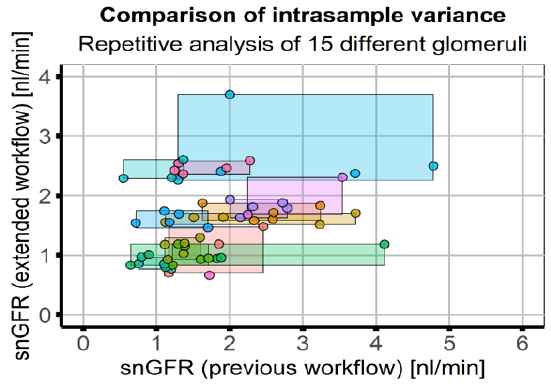
Figure 4. Application and comparison of the workflows in image data of healthy mice. Image data of healthy mice (five animals, 15 glomeruli) was analysed five times by the same researcher using the previous and the extended workflow. Scatter plot of results of the previous (x-axis) and extended workflow (y-axis) with rectangles used to indicate the range of results obtained in one glomerulus. Colours indicate data obtained from individual glomeruli. Intrasample variance with the extended workflow (variance along the y-axis, mean CV=10.35%) was smaller than with the previous workflow (variance along the x-axis, mean CV=38.75%). Both analysis workflows showed similar results (mean snGFR, previous workflow: 1.71±0.91, extended workflow: 1.70±0.78) and a two-sample Kolmogorov-Smirnov test of both result vectors showed that the distributions were not statistically different (p=0.4662).